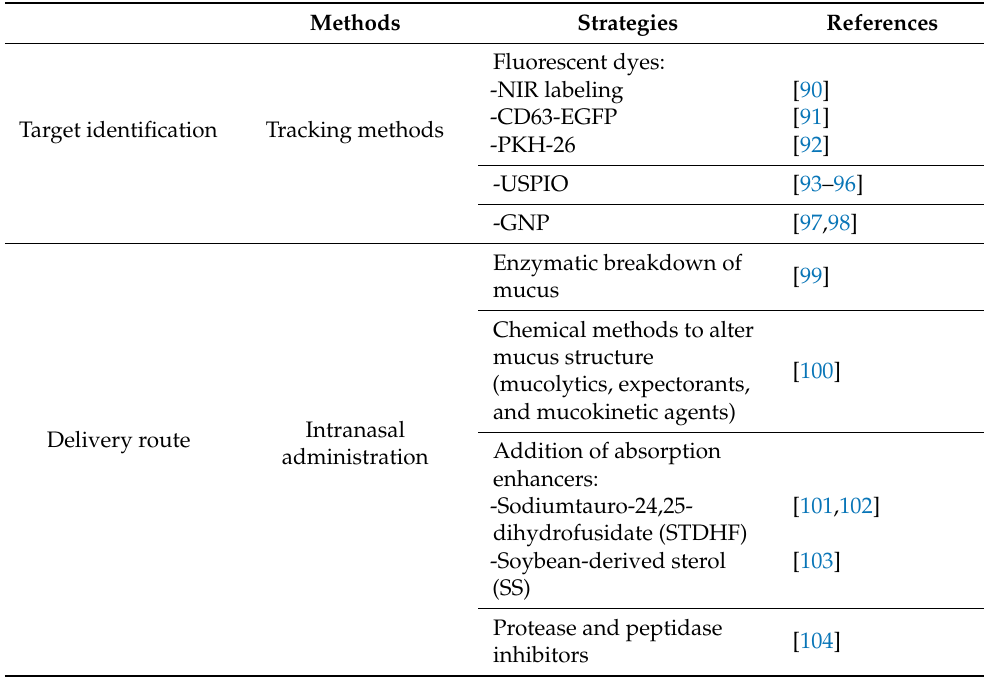
Table 1. Strategies to improve the therapeutic potential of